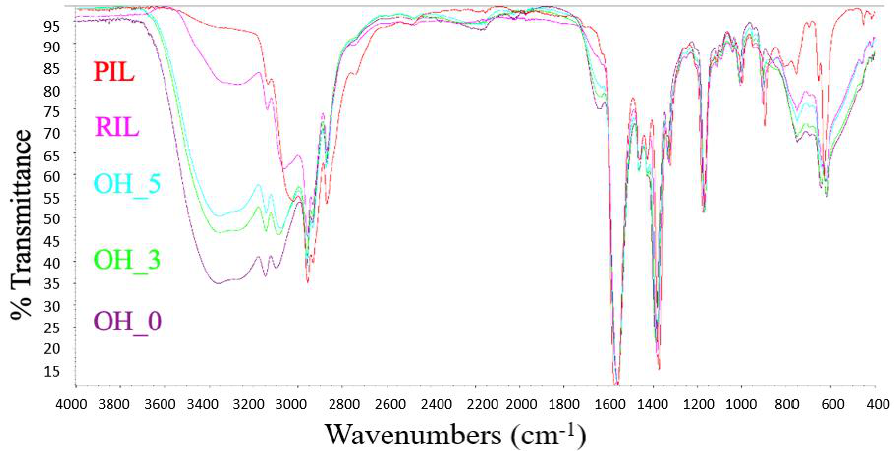
Figure 5. Visual decrease of oh-content in the [BMIM][Ac]-water solution.